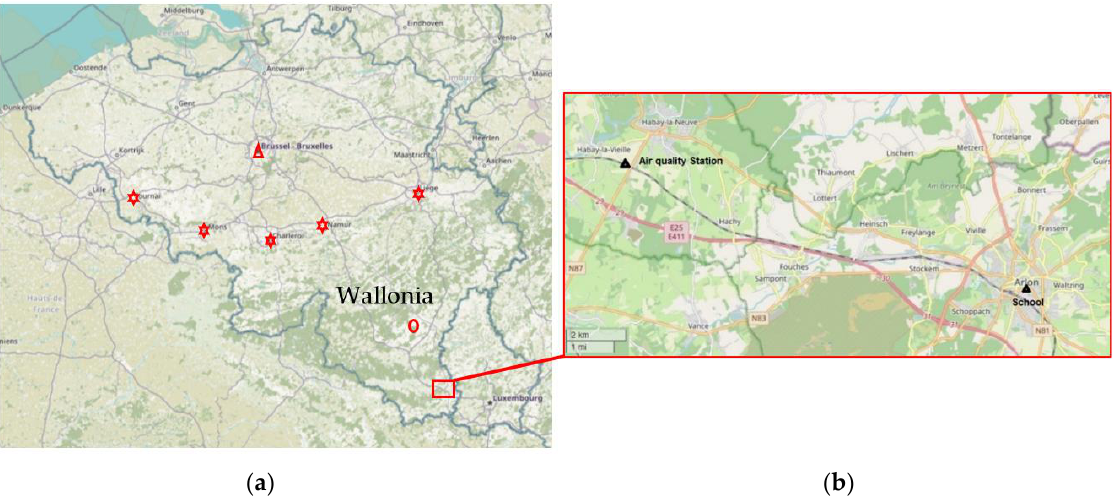
Figure 1. ( a ) Map showing Belgium and the Grand Duchy of Luxembourg. Wallonia is one of three regions in Belgium. Stars indicate the largest cities in Wallonia; the triangle marks the capital, Brussels; and the circle is the meteorological station of Sainte-Ode. ( b ) Detail map showing Arlon and Habay-la-Vieille with its reference station. Map data © OpenStreetMap contributors, CC BY-SA.